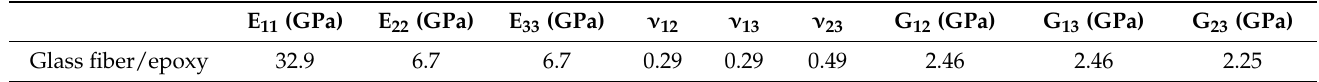
Table 3. The mechanical properties of E-glass fiber/epoxy